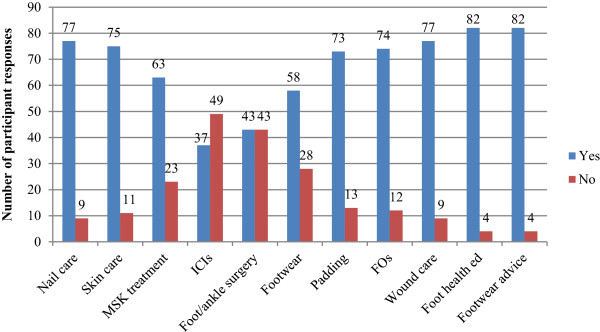
Bar chart indicating the number of ‘yes/no’ responses to the question regarding foot health treatments “Do your patients have adequate access to services providing for these needs:-”.